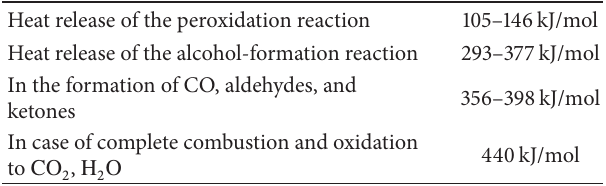
Table 1: Heat release of oxidation